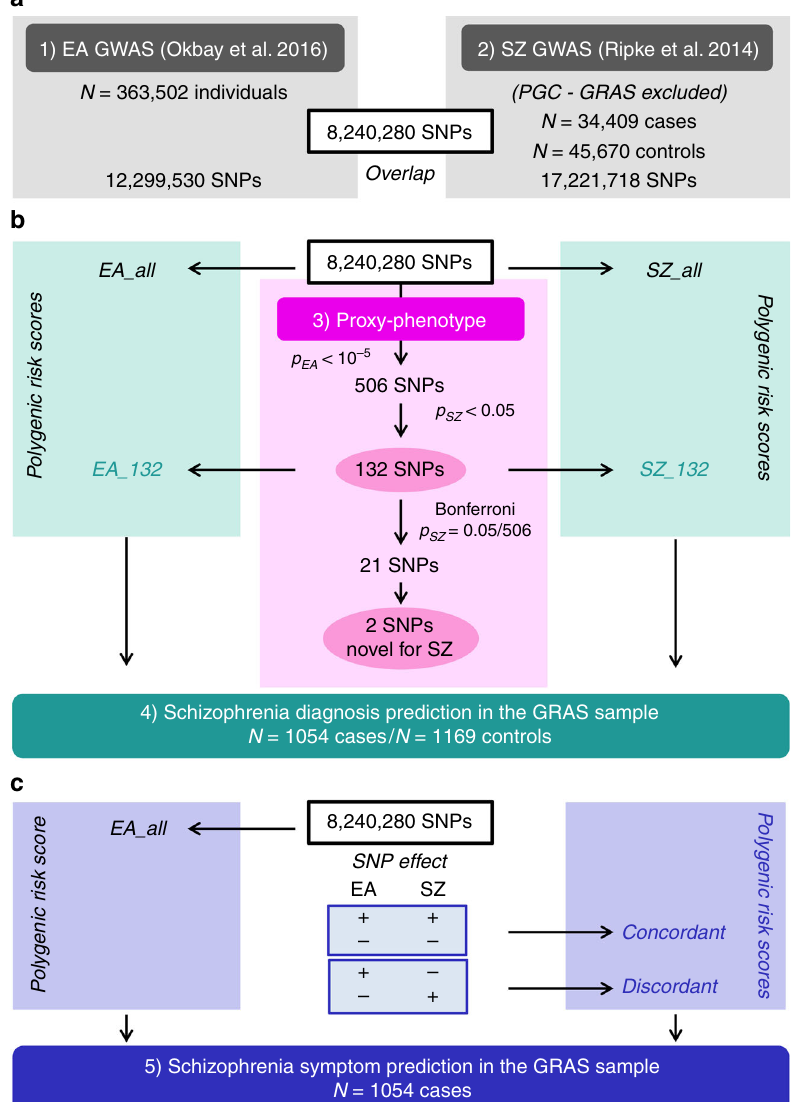
Fig. 1 Work fl ow of the proxy-phenotype analyses. Notes: Educational attainment (EA) and schizophrenia (SZ) GWAS results are based on the analyses reported in refs. 5,8 . All cohorts that were part of the SZ GWAS were excluded from the meta-analysis on EA. The GRAS data collection was not included in either the SZ or the EA meta-analysis. Proxy-phenotype analyses were conducted using 8,240,280 autosomal SNPs that passed quality control. Genetic outliers of non-European descent ( N = 13 cases) were excluded from the analysis in the GRAS data